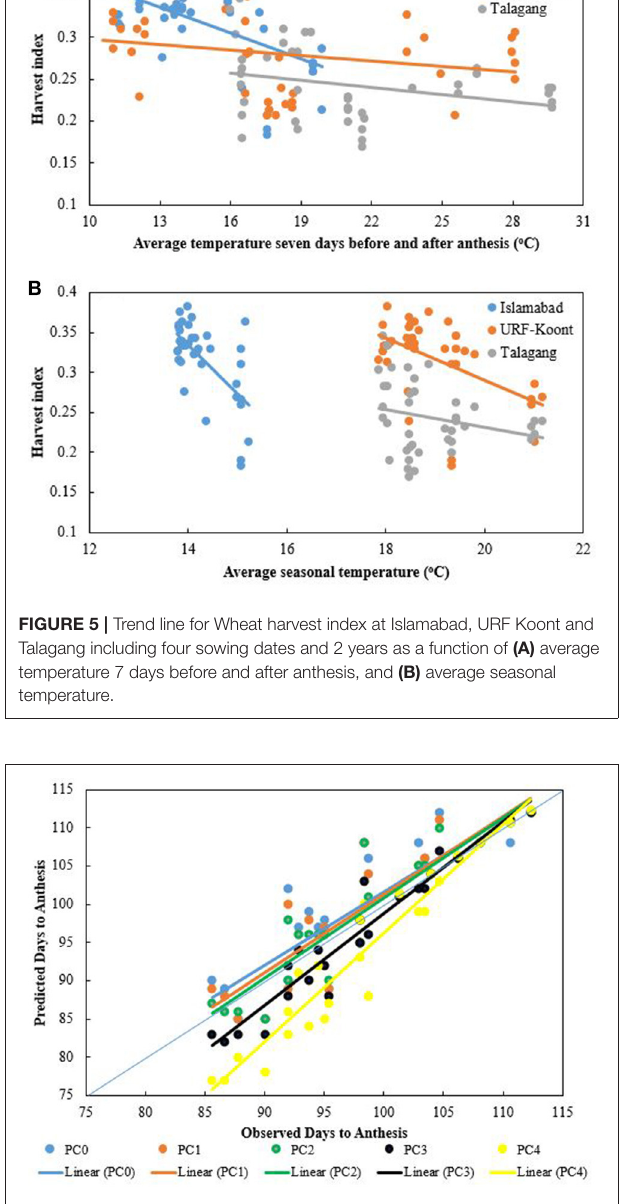
FIGURE 6 | Trend lines for predicted vs. observed number of days to anthesis for four sowing dates, three sites, and 2 years. Predictions are based on the Wang and Engel algorithm (Equation 1) modified by photoperiod effect (Equation 3), the latter using photoperiod coefficients (PC) of 0, 1, 2, 3, and 4.